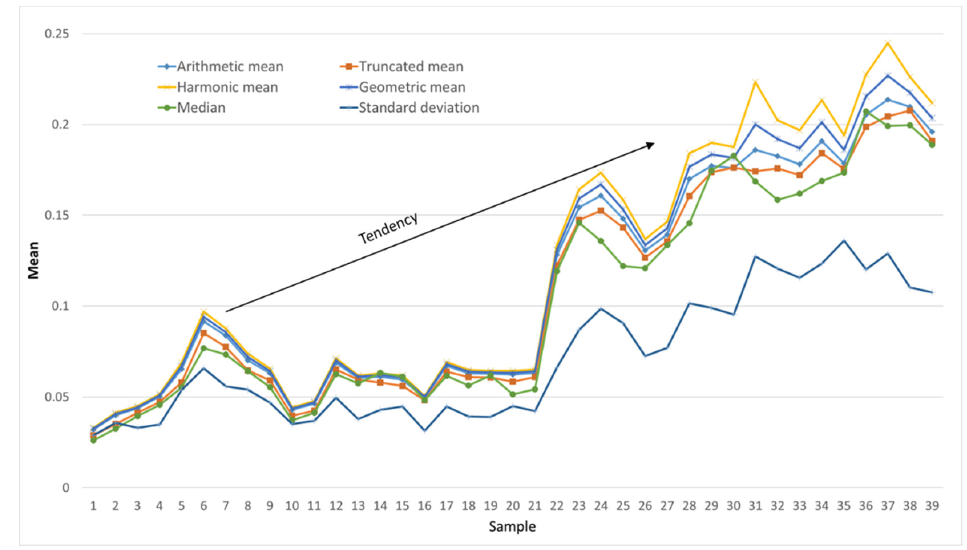
Figure 10. The means, median, and standard deviation calculated for the aluminum plate during the test campaign.